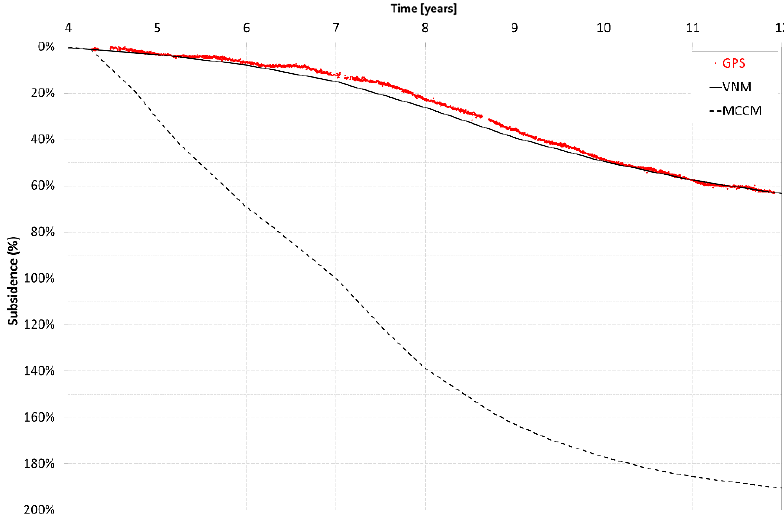
Figure 7. Time evolution of subsidence at platform B: comparison between GPS data, VNM and MCCM